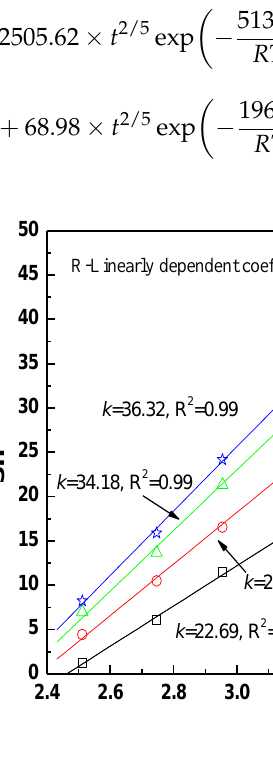
Figure 9. ln( Sh ) vs ln( t ) curves. Sh : the value of volume shrinkage (%), t : time (min), k : reaction rate constant.